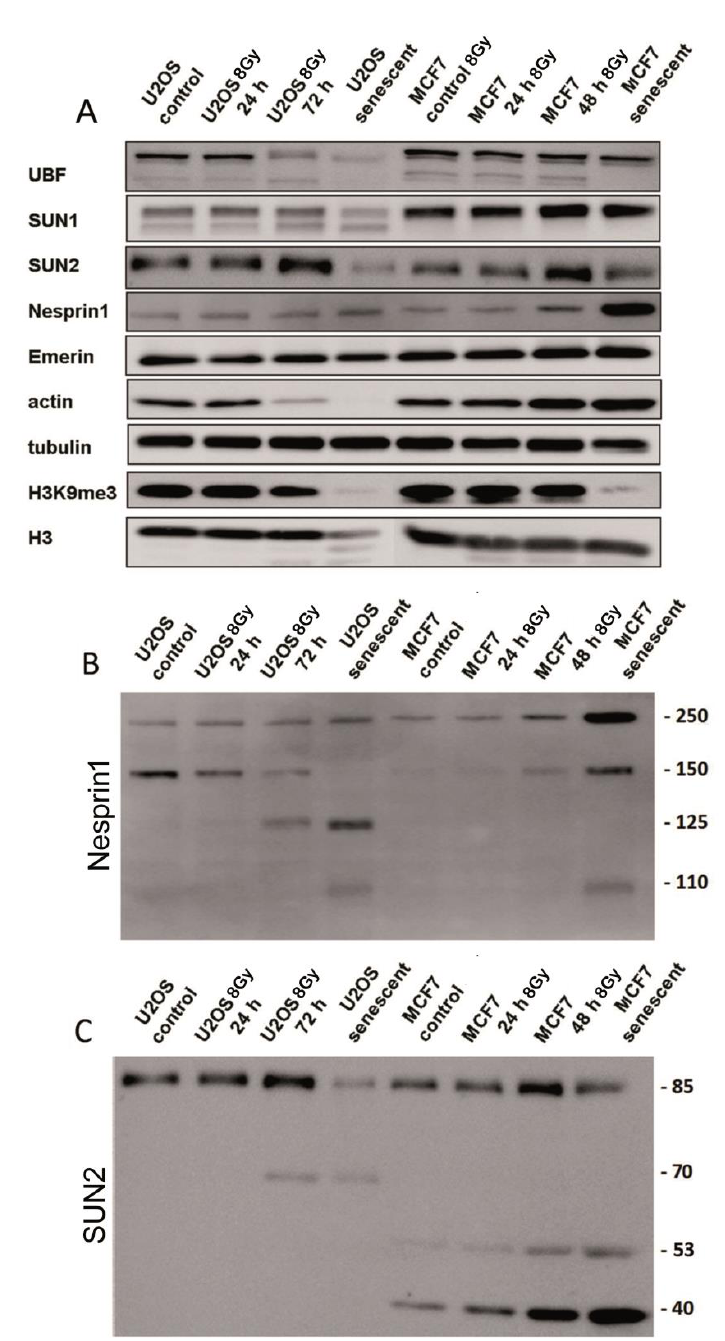
Figure 6. Western blot analysis of protein expression levels ( A ) and their integrity ( B , C ) in control and irradiated MCF7 and U2OS cells. ( A ) Blot cuts showing signals of intact proteins. Note, reduction of SUN2 protein and near absence of H3K9me3 epigenetic modification in senescent cells (7 days post irradiation). ( B , C ) Reactivity of antibodies against nesprin-1 ( B ) and SUN2 ( C ) proteins on the whole blots. Note, significant fragmentation of intact nesprin-1 (250 kDa band) and SUN2 (85 kDa band) in irradiated cells.